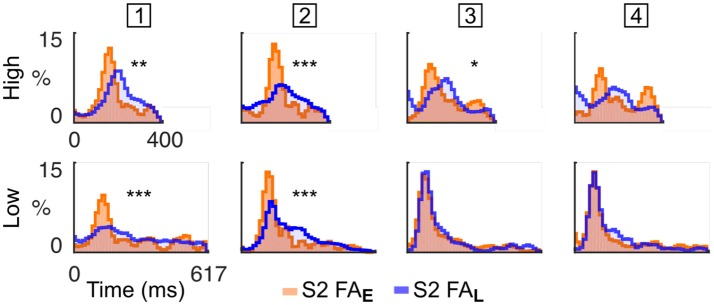
Mice were sensitive to spectral bias as revealed by their false alarm timing. Normalised RT distribution for FA in S2 condition for each mice (one mouse per column, the mouse ID is presented in the square box) computed using all sessions. RT are measured either from High (top) or Low (bottom) tone onsets. The distributions are color-coded based on the block type (Early or Late). RT distributions are smoothed (1 bin std Gaussian filter) for display. The p-value from a KS test comparing the RT distributions in Early and Late conditions is displayed as an indication of response bias (***p < 0.001, **p < 0.01, *p < 0.05; Bonferroni correction factor 8). The first mouse times its FA mainly to the High tones. The second mouse times its FA to the cued tones. The third and fourth mice time their FA mainly to the Low tones.